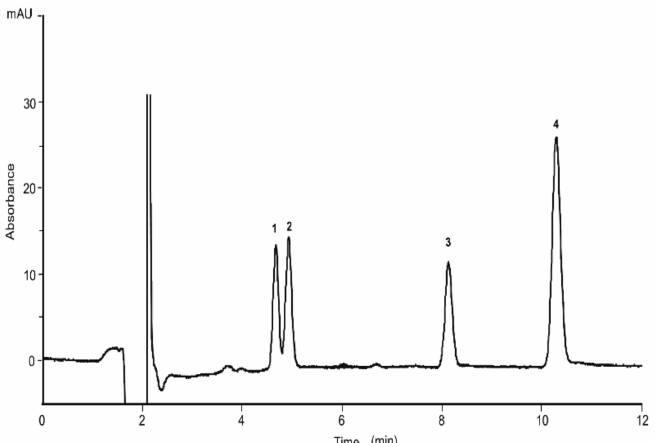
Figure 3. Separation of the four cannabinoids achieved with the short column: capillary column (100 µ m × 15 cm) packed with ChromSpher C18 dp 3 µ m; mobile phase, ACN/H 2 O/formic acid, 80/19/1% ( v / v / v ). UV detection, 214 nm; standard mixture concentration, CBG, CBD and ∆ 9 -THC at the concentration of 15 µ g/mL, CBC at a concentration of 25 µ g/mL; injection time, 15 s; flow rate, 550 nL/min. (1) CBG, (2) CBD, (3) ∆ 9 -THC, (4)